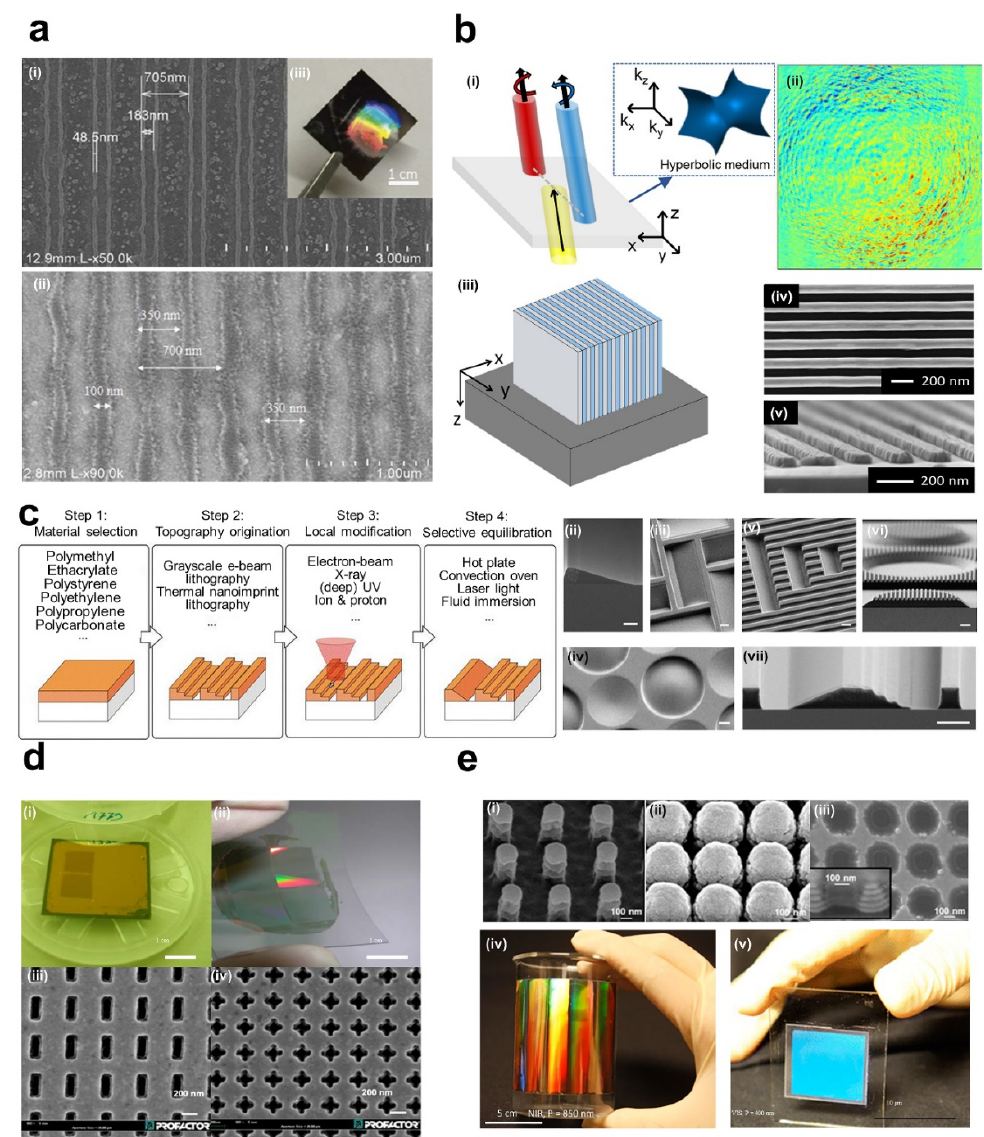
Figure 7. Thermal UV NIL ( a ) (i) SEM image of periodic photoresist pattern by the bare AI grating mask, (ii) pattern by HMMs multilayer, (iii) a photograph of the produced photoresist grating on the polyethylene terephthalate sheet [104]. ( b ) Vertical HMMs fabrication and its optical spin Hall effect. (i) Schematics of optical spin Hall effect in real space, (ii) a measured result of the distribution of transmitted beam. The red and blue colors indicate the LCP and RCP lights, respectively, (iii) schematics of vertical HMMs, the SEM image of (iv) top view and (v) perspective view [34]. ( c ) (i) Schematic flow sequence of the general taste method for the generation of asymmetric 3D grating pattern, (ii–vii) the SEM micrographs of the refined poly methyl methacrylate (PMMA) topographies after exposure of pre-patterned PMMA with high-energy electrons and subsequent thermal annealing (scale bars: 1 μm) [142]. ( d ) (i) Photograph of a single-layered metasurface sample, (ii) transfer-printed gold grating on a flexible foil (iii) SEM image of top view, (iv) SEM image of Swiss-cross metamaterials [155]. ( e ) A 3D negative index metamaterial which has telecom band with the large-area. (i) Top-viewed SEM image before the deposition of NIL with the 850 nm period, (ii) after deposition of 11 Ag/MgF 2 layers, (iii) after removal of polymer posts (inset image shows the tilted view), the photographs of the fabricated results on (iv) the flexible and (v) the rigid substrate [156]. Reproduced with permission from ( a ) [104]; Japan Society of Applied Physics, 2015, ( b ) [34]; American Chemical Society, 2019, ( c ) [142]; CC BY 4.0, ( d ) [155]; IOP Publishing Ltd., 2011, and ( e ) [156]; American Chemical Society, 2014.